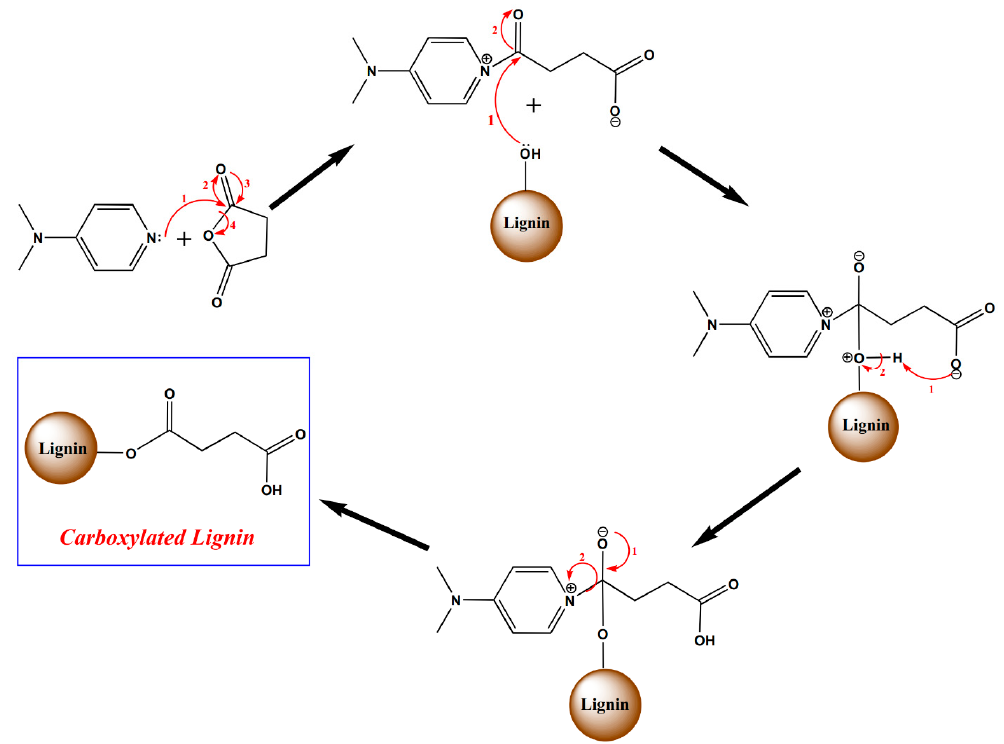
Figure 1. Mechanism of lignin carboxylation.